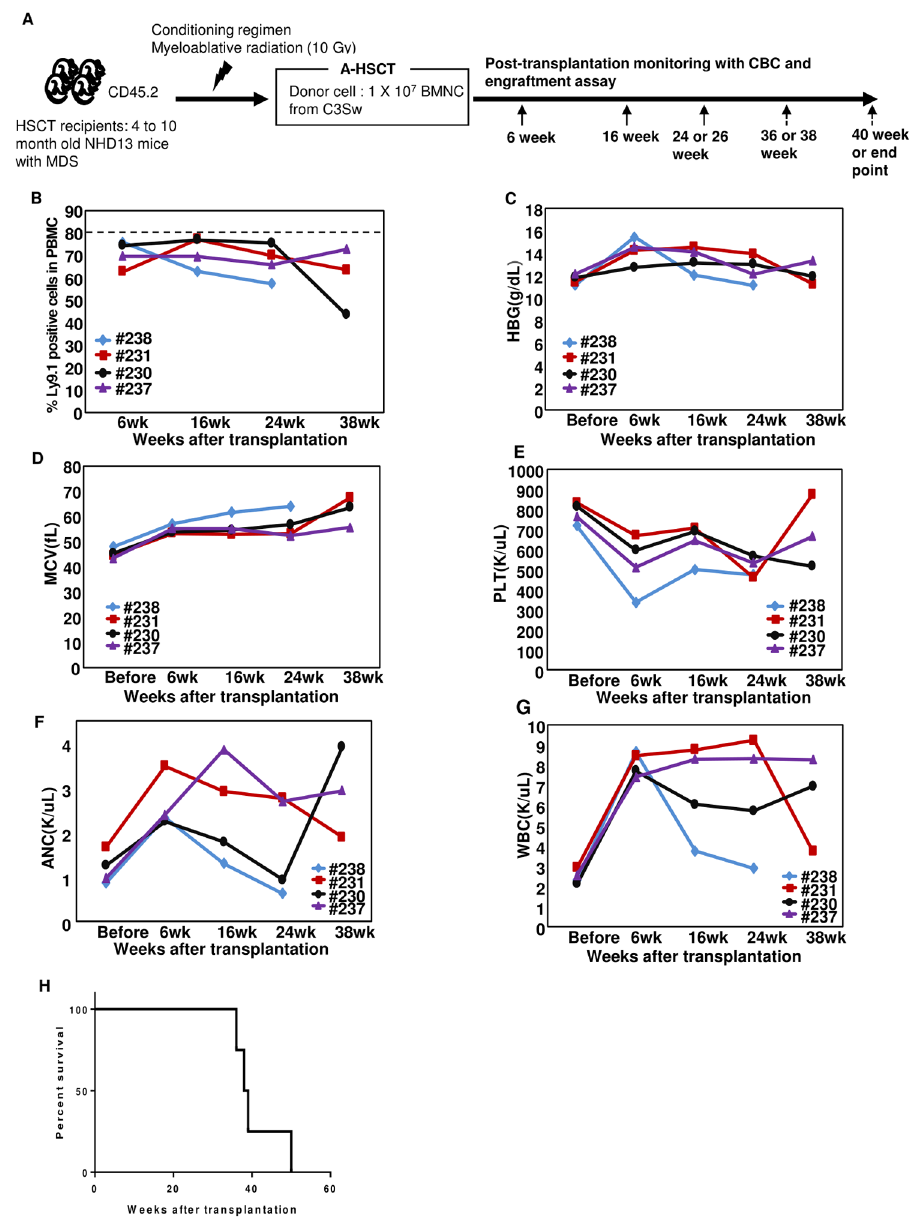
Fig 2. Evaluation of allogeneic HSCT (A-HSCT) using the NHD13model of MDS. (A) Schematic illustration of AHSCT experiment. (B) Engraftment of donor cells was evaluatedusing an anti-Ly9.1 antibody. The dotted line indicatesLy9.1 positivity(79.9 ± 2.5%) in the peripheral blood of 5 healthyC3H.sw donor mice, as a reference for full donor chimerism. (C) HGB, hemoglobin. (D) MCV, Mean corpuscular volume. (E) PLT, platelet count. (F) ANC, absolute neutrophil count. (G) WBC, white blood cell count. (H) Survival curve for this cohort only (n = 4). Data presentedhere is representative of three independent experiments; complete data for all experiments is presentedin S3